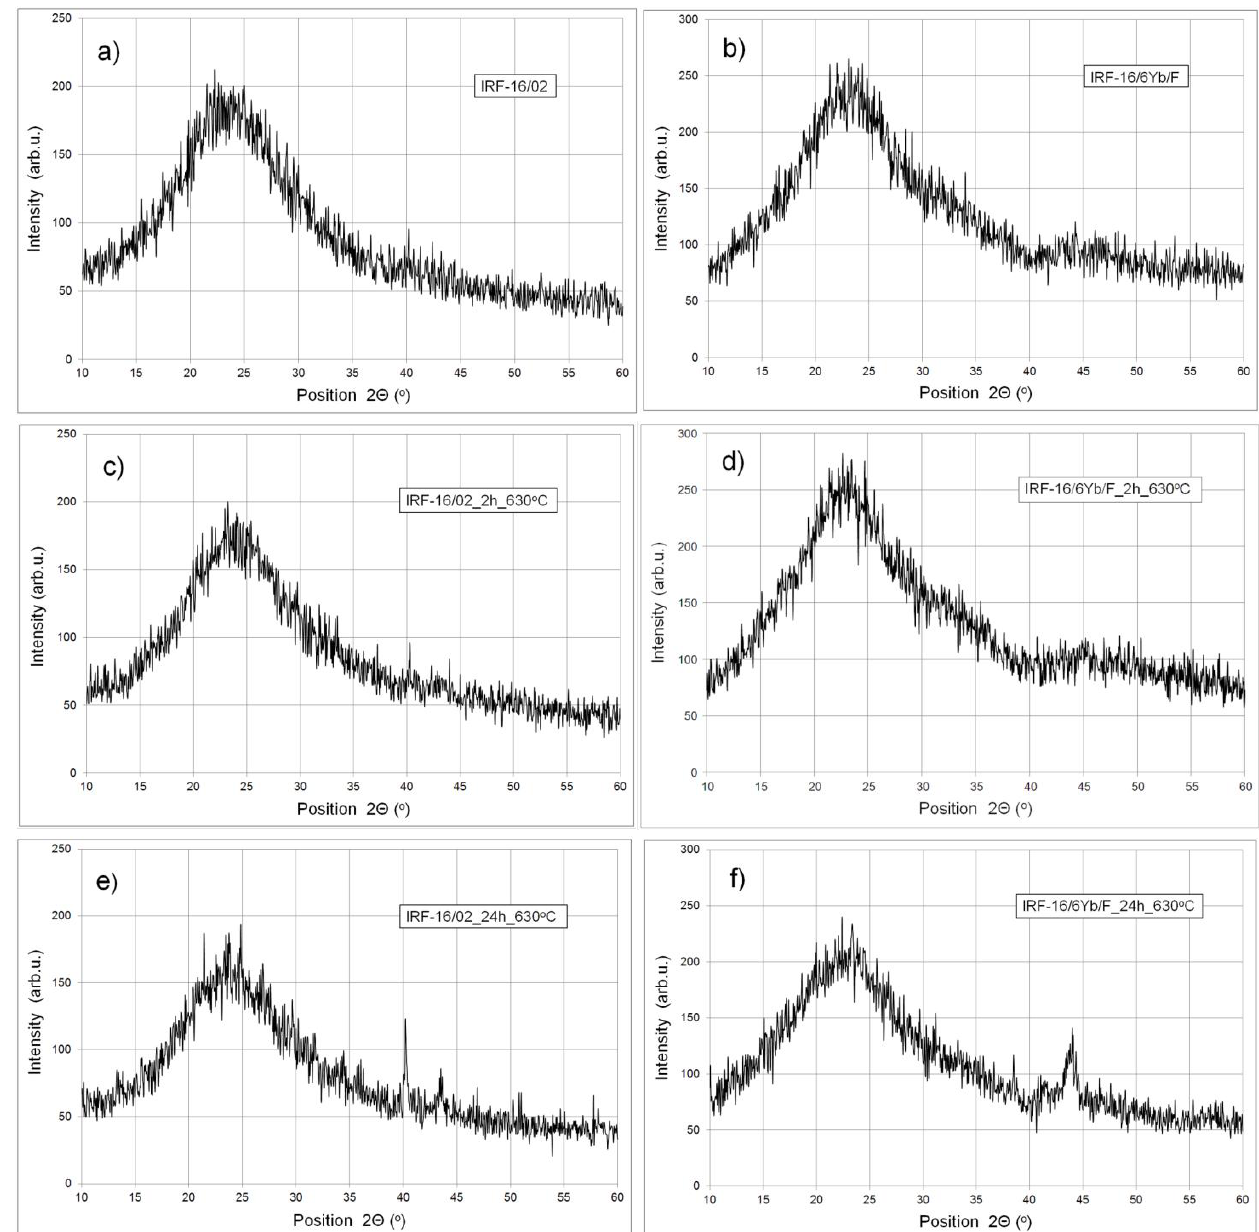
Figure 5. X-ray diffractograms of the IRF-16/02 and IRF-16/6Yb/F glasses (from large batch meltings): ( a , b ) without thermal treatment; ( c , d ) treated 2 h at 630 °C; ( e , f ) after treatment during 24 h at 630